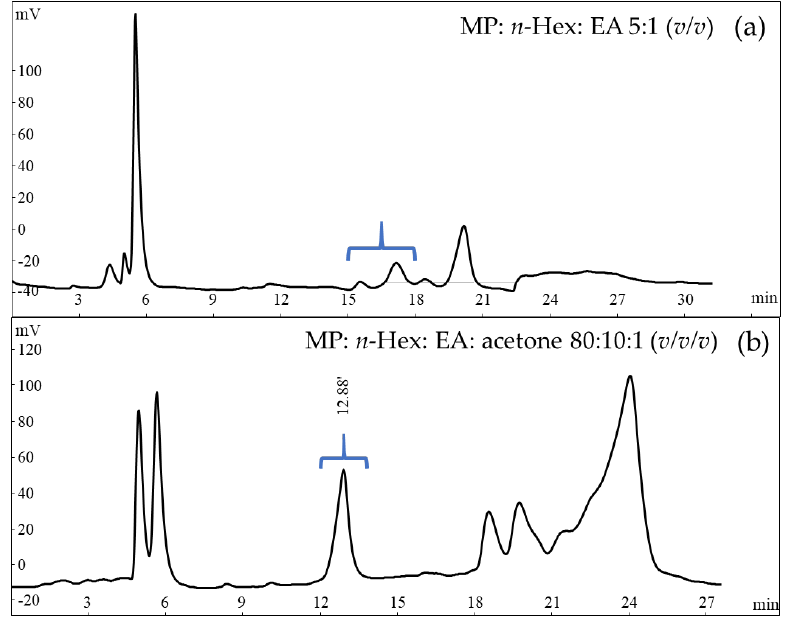
Figure 3. Representative HPLC trace of compound AQ20. ( a ) Eluent from RT 15-18 min was collected in one bottle and subjected to semi-preparative HPLC for further separation. ( b ) Peak at RT 12.9 min was collected and identified as AQ20. MP, mobile phase condition.